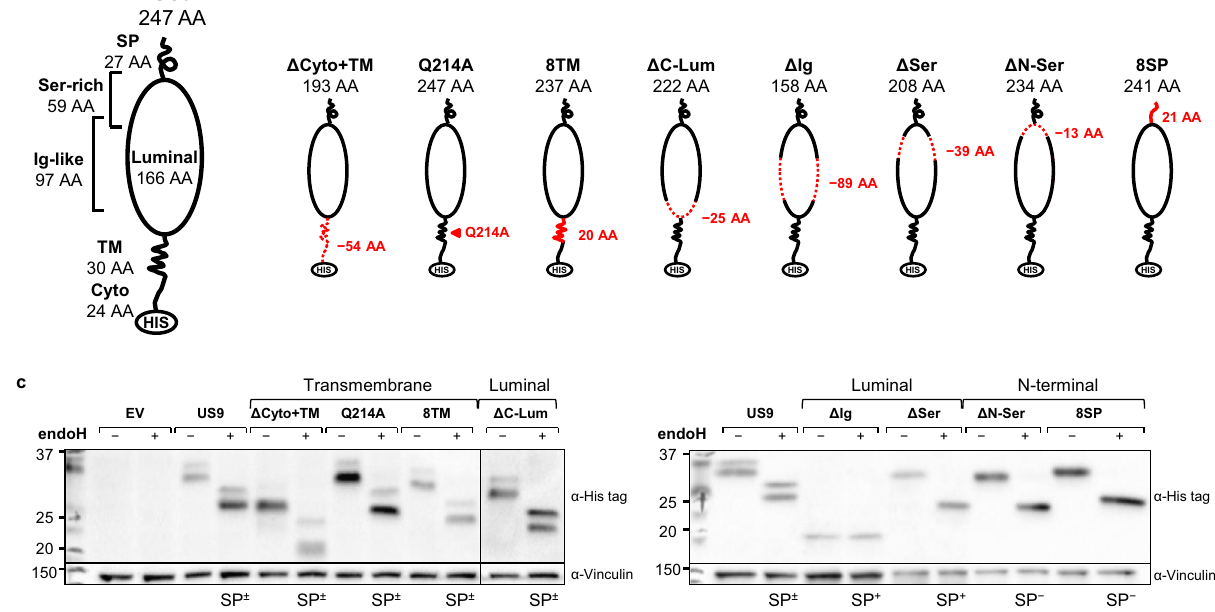
Fig. 2 Delayed US9 SP cleavage requires the N-Ser area. a Diagram of US9 domains: signal peptide (SP), serine-rich compositionally biased area (Ser), Ig-like fold (Ig), transmembrane (TM), cytosolic (Cyto), 6XHis tag (HIS). Total protein length without tags and the length of each domain in amino acids (AA) are indicated. b Diagrams of US9 deletion and substitution mutants arranged according to the mutated domain. The total length of each construct without tags and of each modi fi ed domain are indicated. Dashed red lines show deleted domains, solid red lines show substitutions with a homologous US8 sequence, arrow shows a single mutated residue. c The US9 mutants described in ( a , b ) were expressed in RKO MICA*008-HA cells. Lysates prepared from the indicated transfectants were untreated ( − ) or digested with endoH ( + ) and then immunoblotted. Mutants are grouped by mutated region (indicated). Anti-His tag was used to visualize protein expression, with anti-vinculin as loading control. Annotation beneath the panel indicates deglycosylated US9 forms with, without, or both with and without the SP (SP + / − /± ). Different panels depict separate gels. Different segments of the same gel are shown together for clarity in the left panel. Representative of two independent repeats. See also Fig.